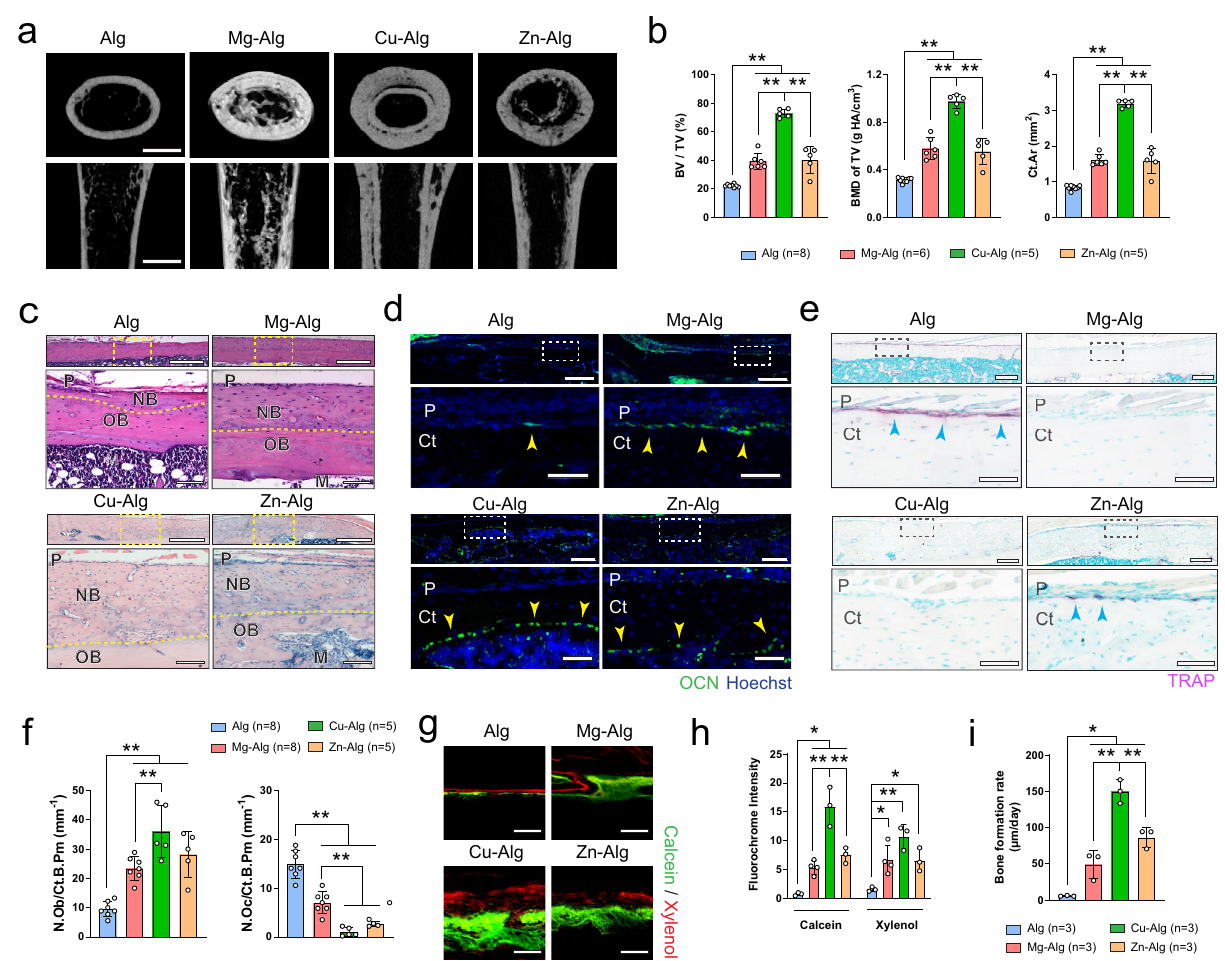
Fig. 1 Divalent cations released from alginate induce new bone formation. a Reconstructed micro-computed tomography ( µ CT) images (scale bars = 1 mm) showing the new bone formation in mouse femurs grafted with Mg 2 + -, Cu 2 + -, or Zn 2 + -releasing alginate. Pure alginate grafted mice serve as control. b Corresponding measurements of bone volume fraction (BV/TV), bone mineral density (BMD of TV), and cortical bone area (Ct.Ar). c Representative images of hematoxylin and eosin (H&E) staining showing periosteal new bone formation ( n = 3). Lower images (scale bars = 100 µ m) are high-resolution versions of the boxed regions in the upper images (scale bars = 500 µ m). P, periosteum; NB, new bone; OB, old bone; M, marrow. d Representative immuno fl uorescent images showing the presence of osteocalcin + (OCN + ) osteoblasts on the cortical bone surface. Lower images (scale bars = 50 µ m) are high-resolution versions of the boxed regions in the upper images (scale bars = 200 µ m). P, periosteum; Ct, cortical bone. e Representative images of tartrate-resistant acid phosphatase (TRAP) staining showing the presence of TRAP + osteoclasts on the cortical bone surface. Lower images (scale bars = 100 µ m) are high-resolution versions of the boxed regions in the upper images (scale bars = 400 µ m). f Histomorphological analysis of osteoblast (N.Ob/Ct.B.Pm) and osteoclast (N.Oc/Ct.B.Pm) numbers on the cortical bone surface. Representative images of calcein/xylenol labeling showing periosteal new bone formation ( g , scale bars = 100 μ m), quantitative analysis of fl uorescence intensity of calcein and xylenol ( h ), as well as corresponding measurement of bone formation rate ( i ). Data are mean ± standard deviation (s.d.) * P < 0.05, ** P < 0.01 by 1-way analysis of variance (ANOVA) with Tukey ’ s post hoc test. Source data are provided as a source data fi